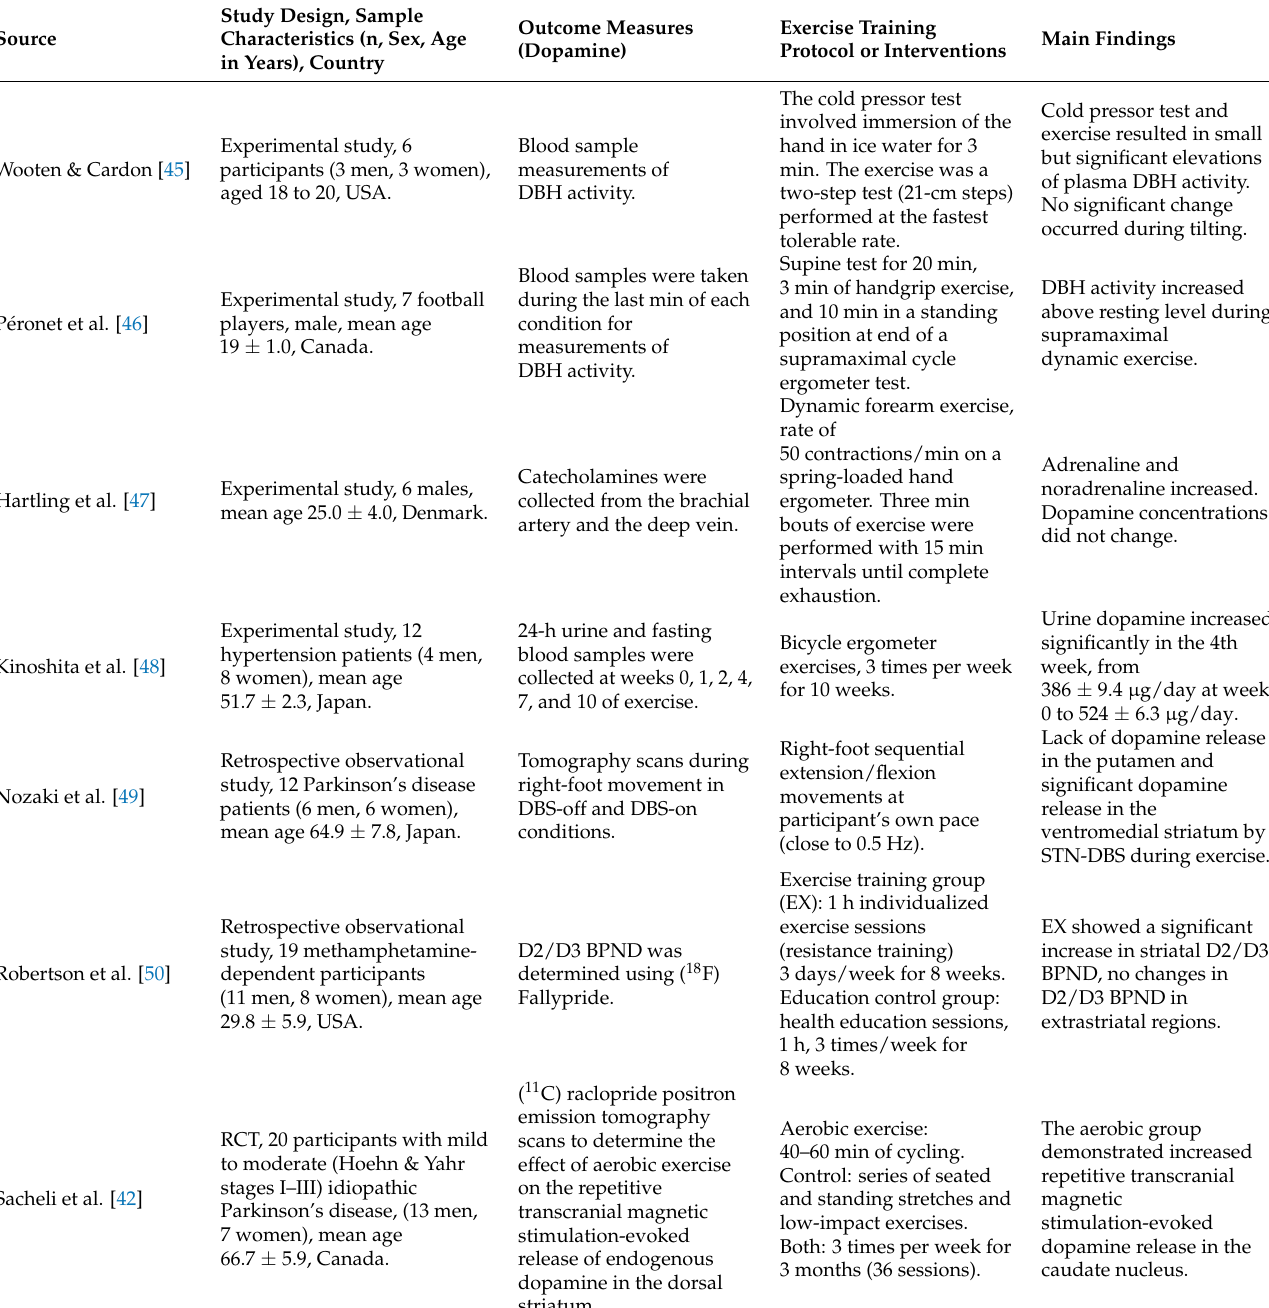
Table 2. Characteristics and the main results of studies analysing the effect of exercise on